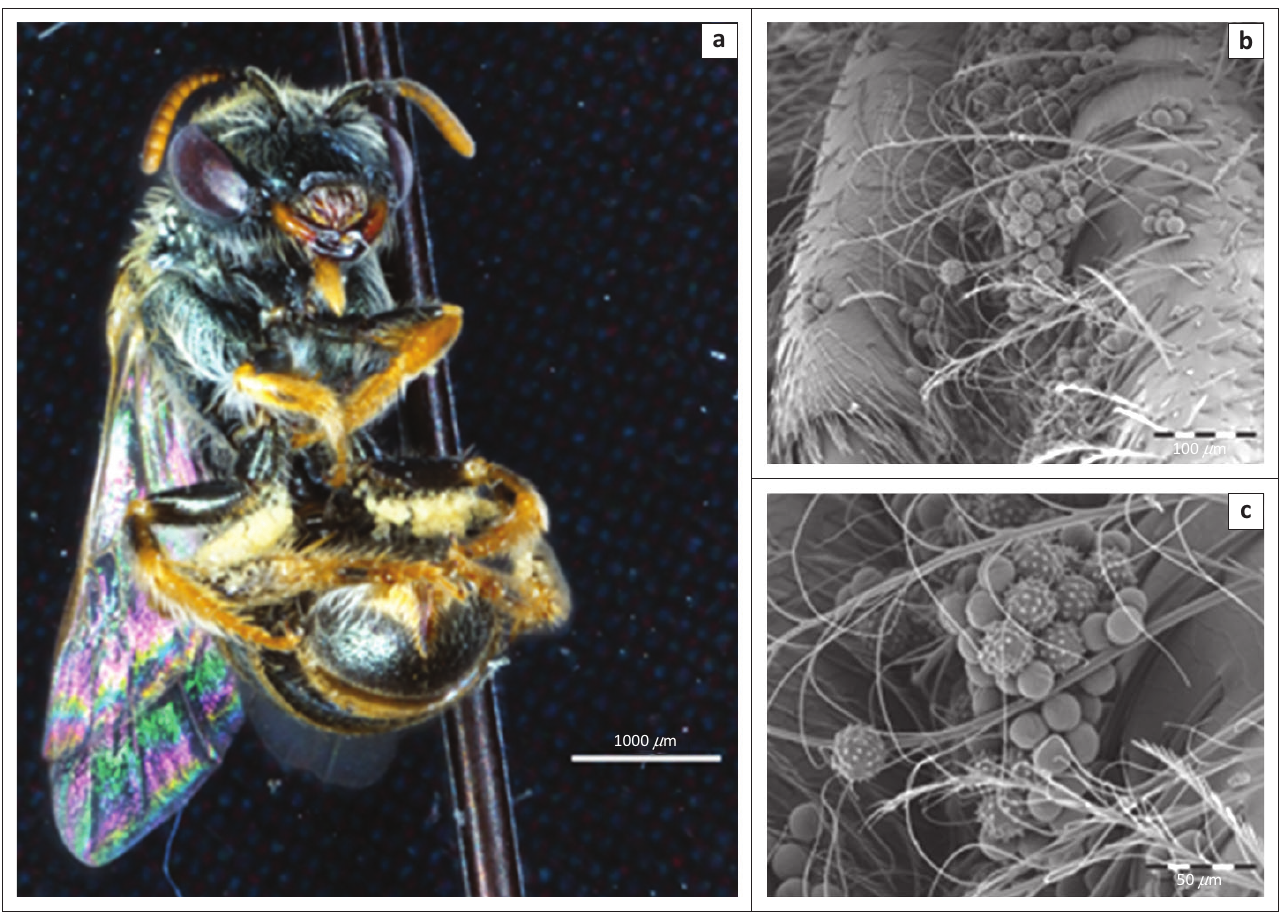
FIGURE 8: (a) Stereomicrograph of Seladonea sp. (Halictidae) . (b, c) Scanning electron microscope micrographs of Frithia humilis pollen grains in the pollen